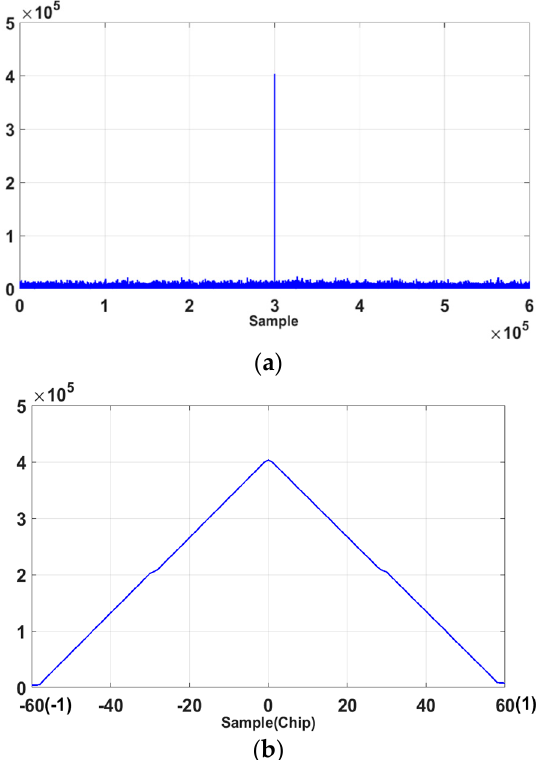
Figure 9. The CCF for the DM method (33-chip delay); ( a ) Correlation plot for 10,230 chips (600,000 samples); ( b ) Correlation plot for ± 1 chip (59 samples) around the correlation peak.